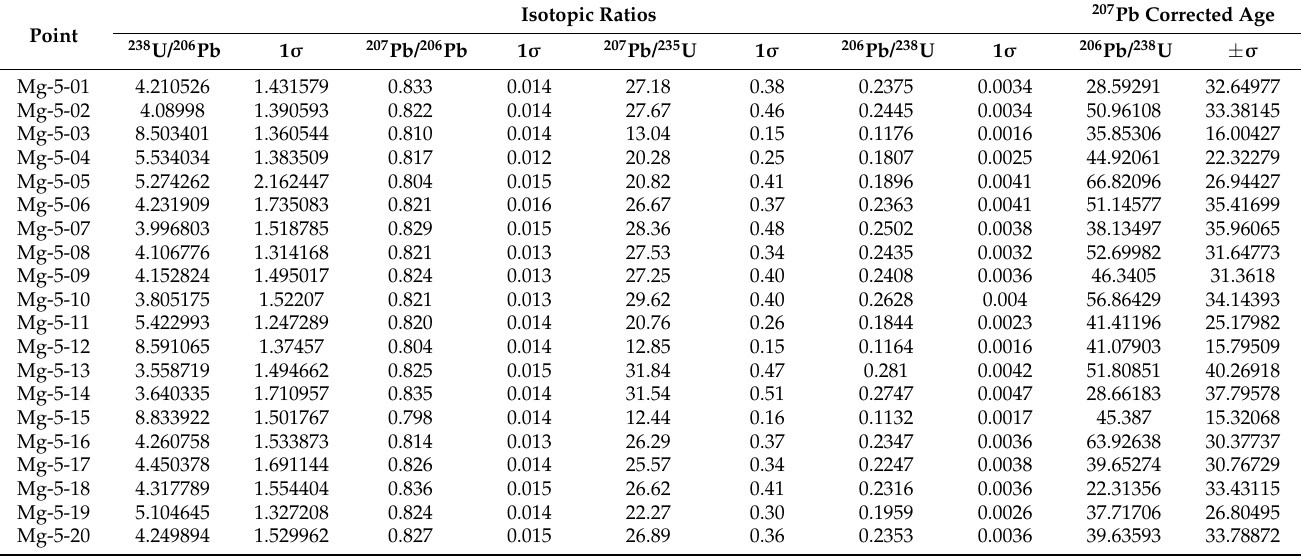
Table 4. U–Pb dating data of MG-5.